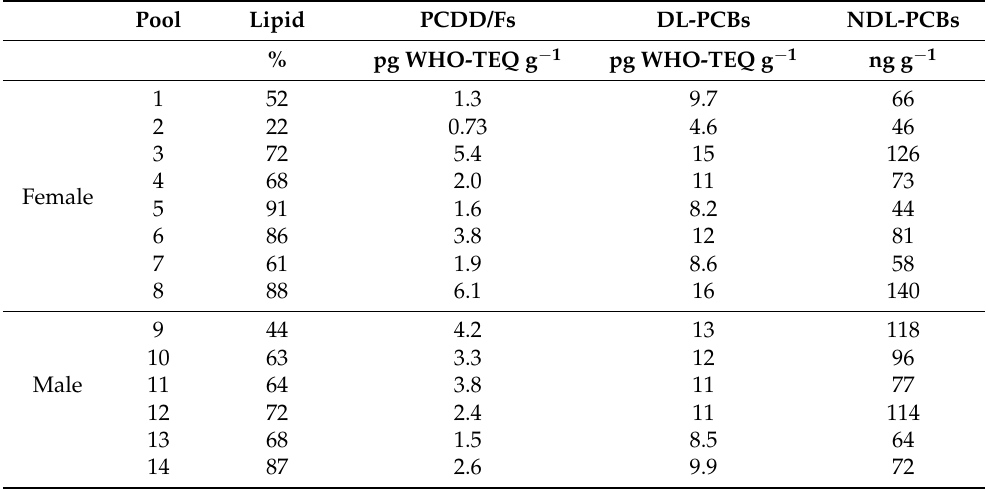
Table 3. PCDD/Fs and PCBs levels in fat tissue. Results are expressed as upper-bound on lipid basis. Pool Lipid